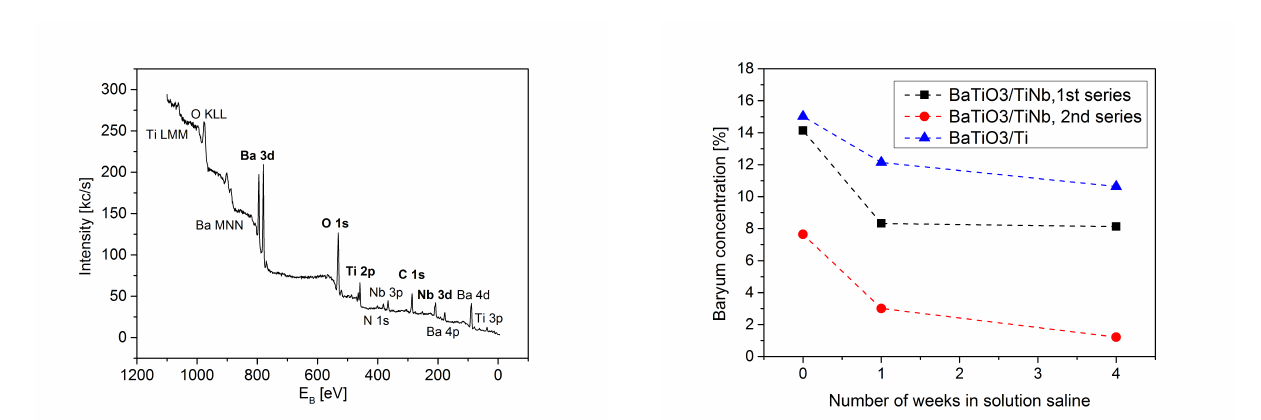
Figure 1. Photoelectron spectrum BaTiO substrate after preparation of sample. Visible peaks (photoelectron as well as Auger) are marked, those used to calculation of element concentration are in bold.